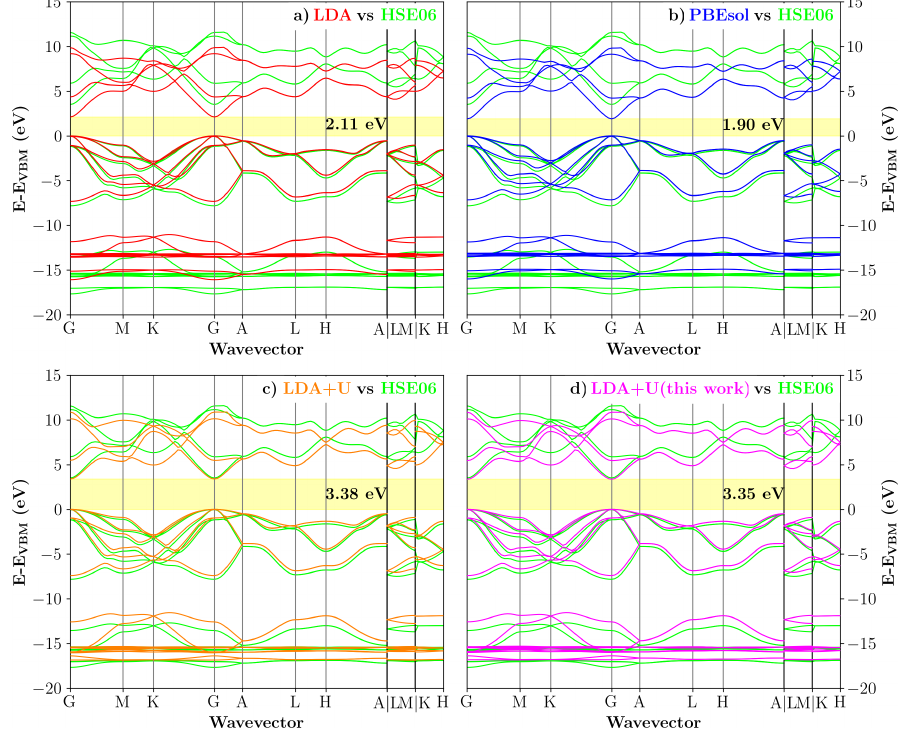
Figure 2. Hybrid DFT (HSE06) electronic band-structure of GaN compared to: ( a ) LDA, ( b ) PBEsol, ( c ) LDA+U with U-parameters taken from Carvalho et al. [14], and ( d ) LDA+U with U-parameters obtained in this work. The shaded area highlights the